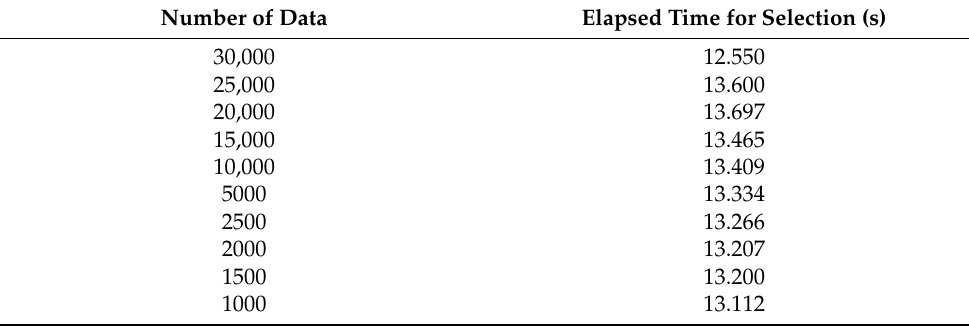
Table 6. Time required for data selection (Grid Ratio: 0.005).